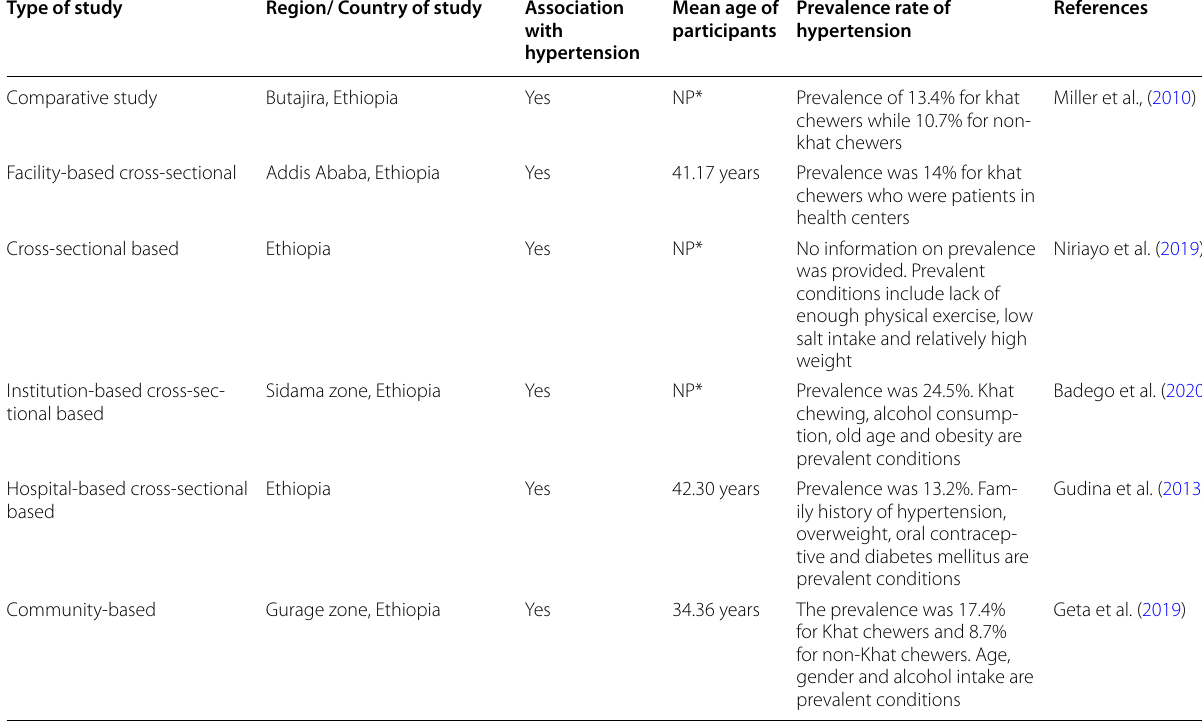
Table 8 Selected studies on the association between hypertension and khat